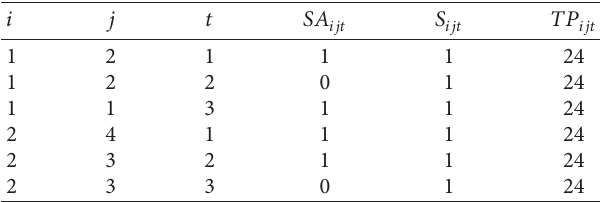
Table 7: Small dataset results of the base LSSP MILP: